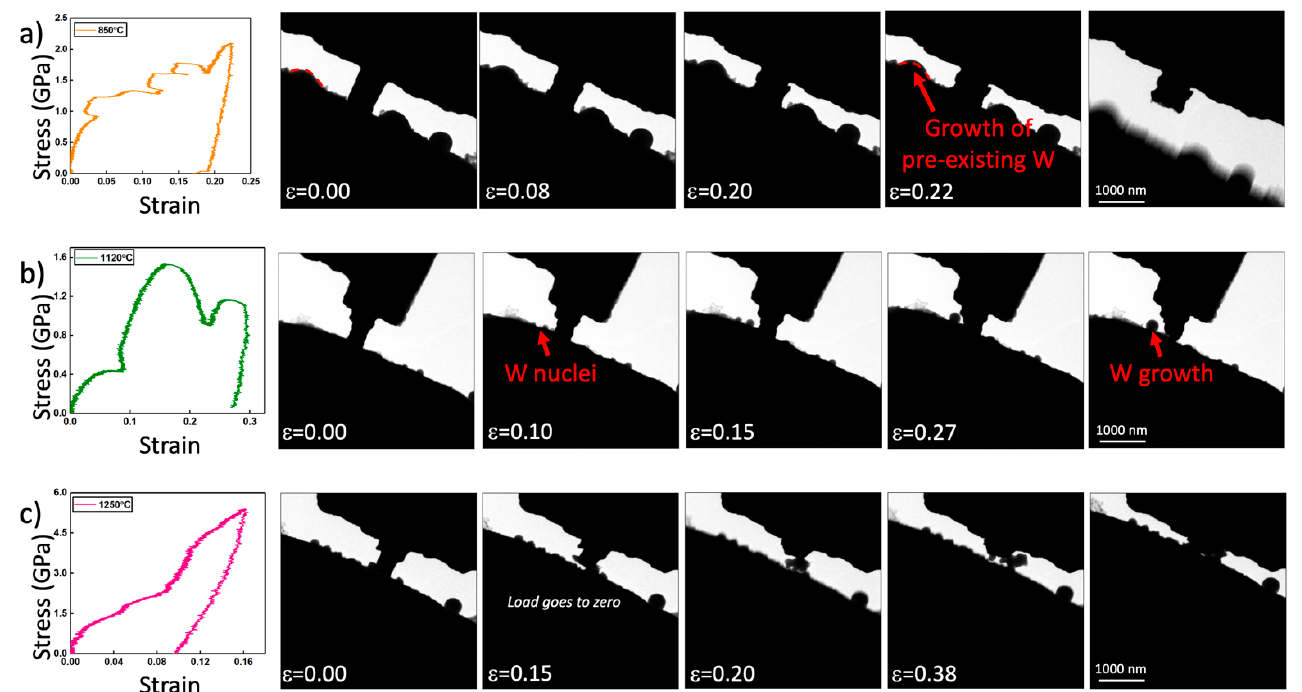
Figure 3. A series of nanopillar compression experiments performed at different temperatures between 850 °C and 1250 °C including time-lapse images and stress–strain curves. At 850 °C, shear is observed in the pillar along with some growth of tungsten particles that pre-existed on the surface of the YSZ indenter. Experiments performed at 850 °C demonstrate the nucleation and growth of tungsten particles on the YSZ indenter as the pillar is compressed. At 1250 °C, the pillar undergoes initial loading but begins reacting rapidly. The load returns to zero as the pillar continues to react. The samples in this figure were tested sequencially ( b ), followed by ( c ) and then ( a ), which accounts for W particles existing on the indenter surface prior to loading.